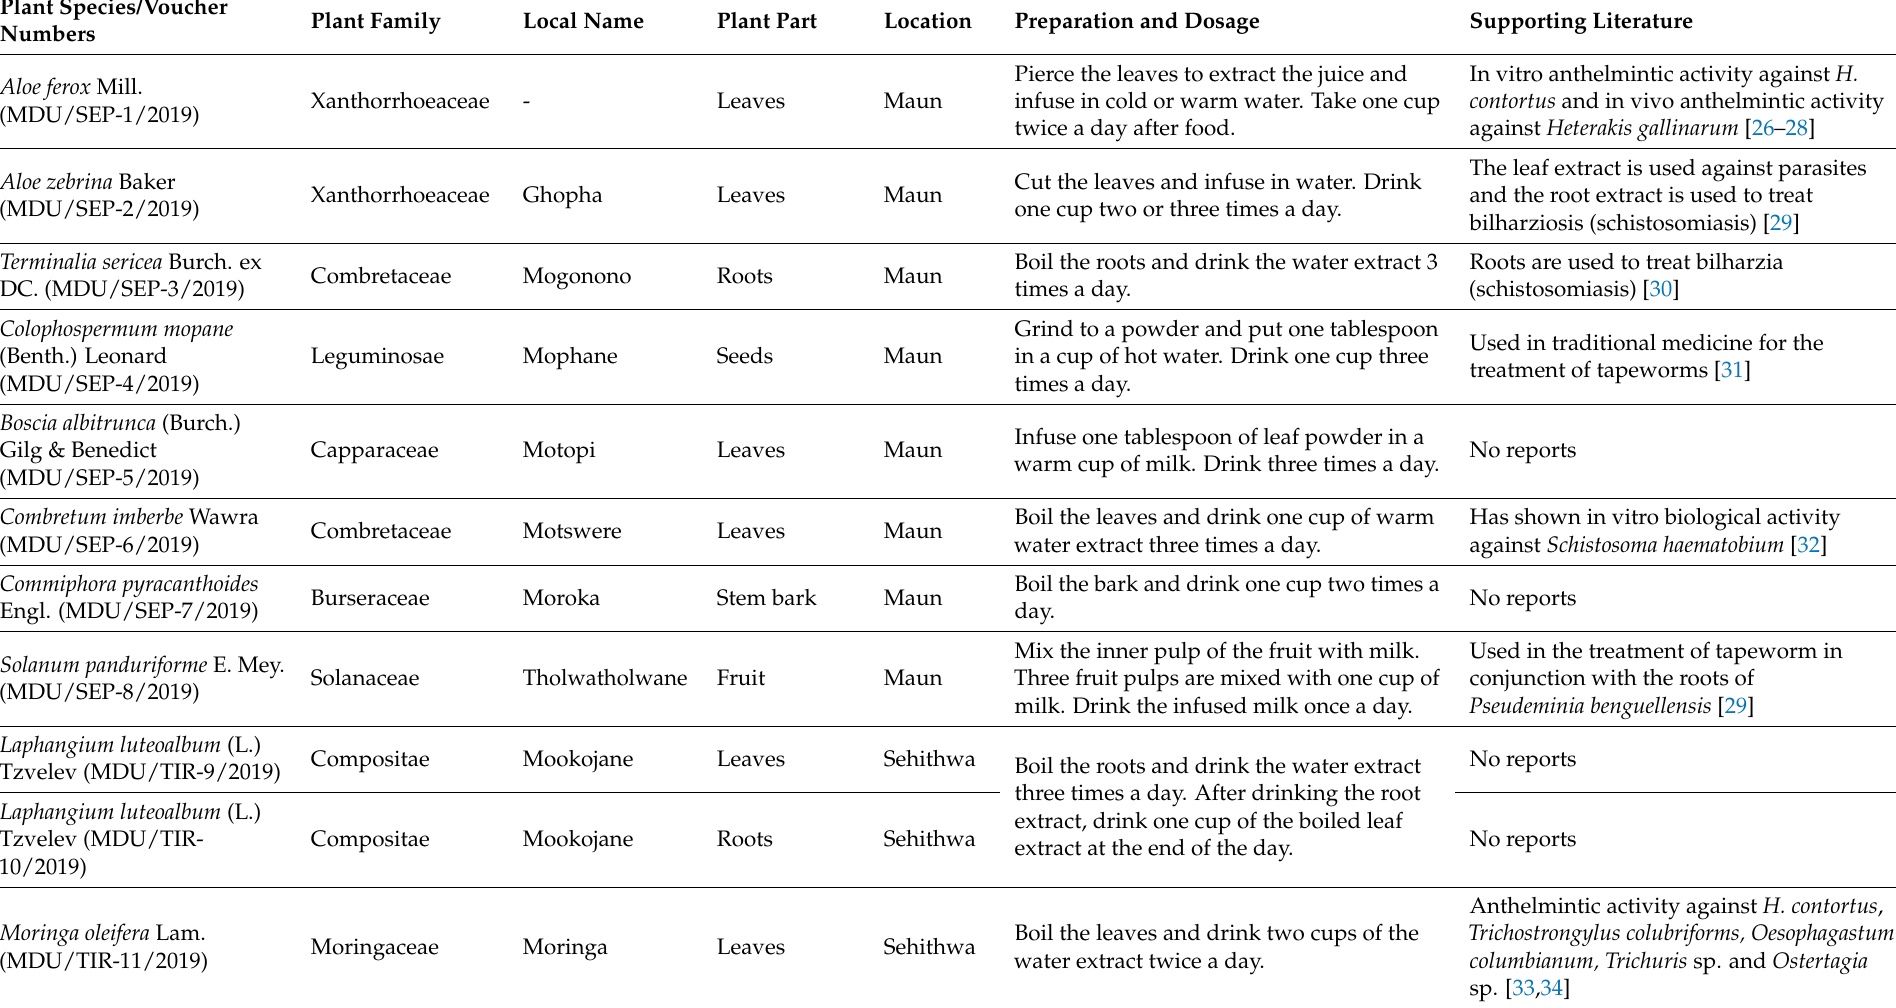
Table 1. Traditional medicinal anthelmintic plants used in North West District,